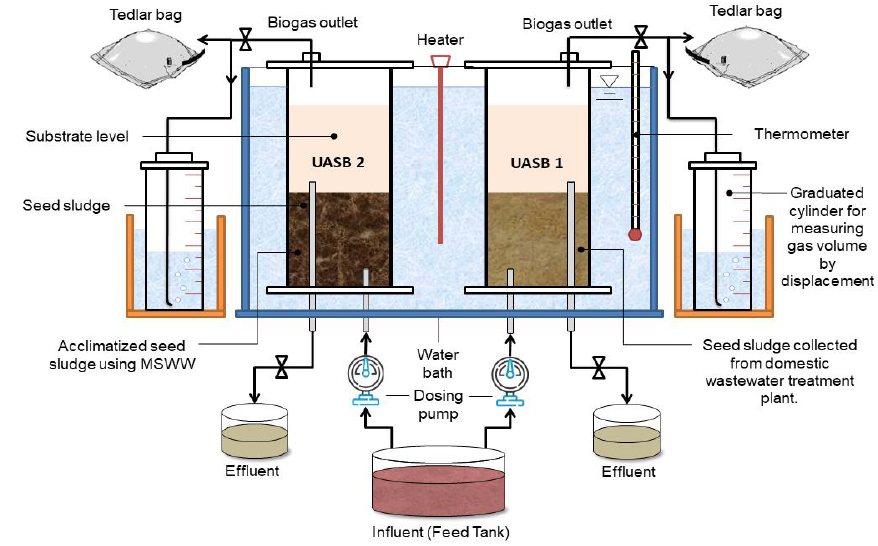
Figure 1. Schematic diagram of UASB 1 and 2 reactors.